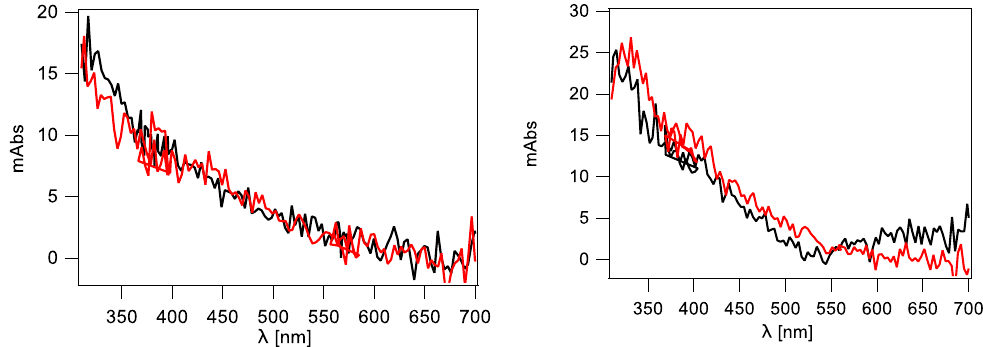
Figure 6. Transient absorption spectra recorded using ICCD in N 2 O-saturated phosphate bu ff ered (50 mM) aqueous solutions containing 5 (cid:48) -CGT ATG GTA TCG-3 (cid:48) (ODN1) (left panel) and 5 (cid:48) -CGA TGG GGT ACG-3 (cid:48) (ODN3) (right panel) at natural pH: ( − ) 1 µ s and ( − ) 50 µ s after electron pulse.